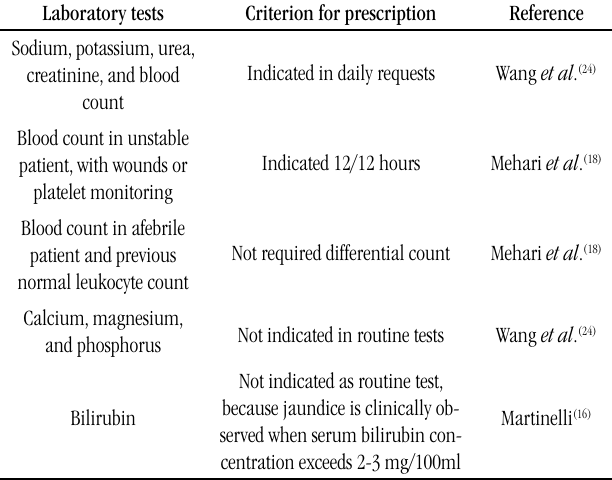
tABLE 1 − Classification criteria for of unnecessary laboratory